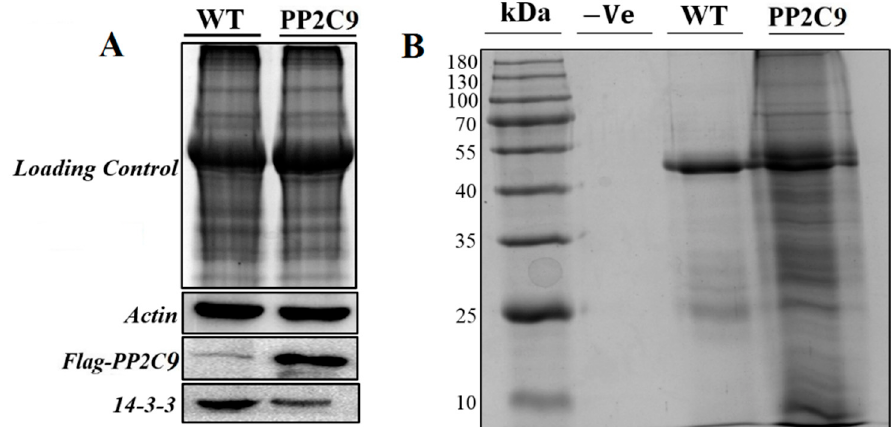
Figure 9. ( A )Western blotting of differentially expressed proteins in PP2C9TL and WT at 10 DAF stage. The top photo shows the SDS-PAGE separation of two protein samples used as loading control. The bottom photo shows gel transferred onto nitrocellulose membrane for western blotting to detect actin, anti-Flag- PP2C9 , and 14-3-3 protein for WT and PP2C9TL at the 10 DAF stage. ( B ) Co-immunoprecipitation (Co-IP) assays of PP2C9 associated protein analyzed by SDS-PAGE. Protein molecular weight marker, negative control without antibodies, WT protein, and the third is the PP2C9TL protein. 2.8. Identification of PP2C9 Associated Protein by Co-Immunoprecipitation (CO-IP) and Mass Spectrometry.